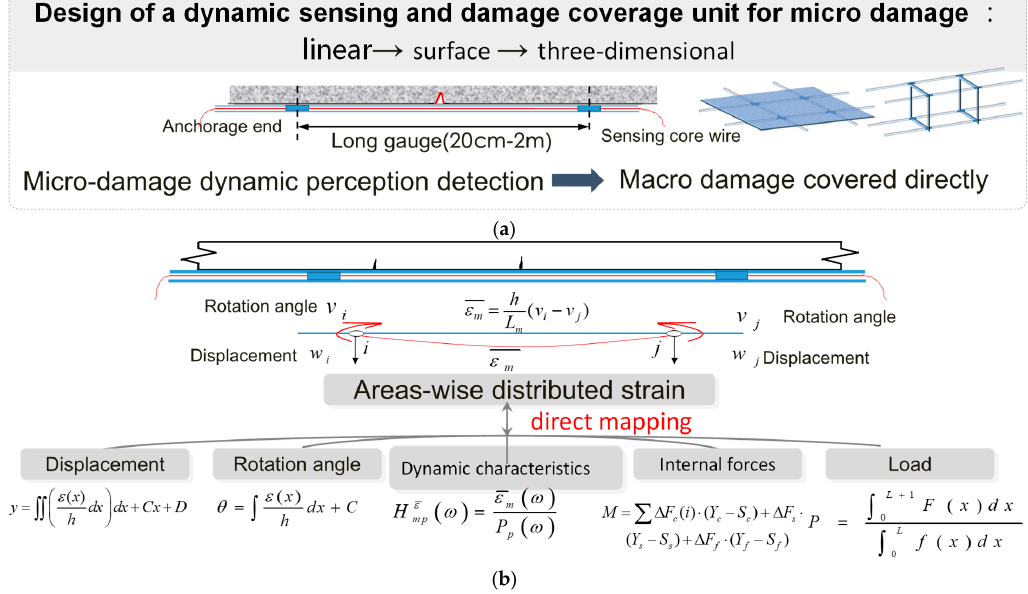
Figure 1. The unique characteristics of area-wise distributed monitoring. ( a ) Macro/micro combination, damage cover unit. ( b ) Direct mapping relationship between area-wise distributed strain and structural parameters.